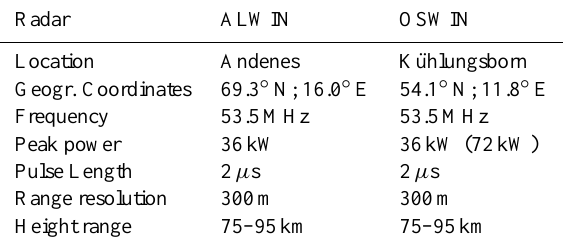
Table 1. Technical details of the VHF radars in Andenes and K¨uhlungsborn for investigations of